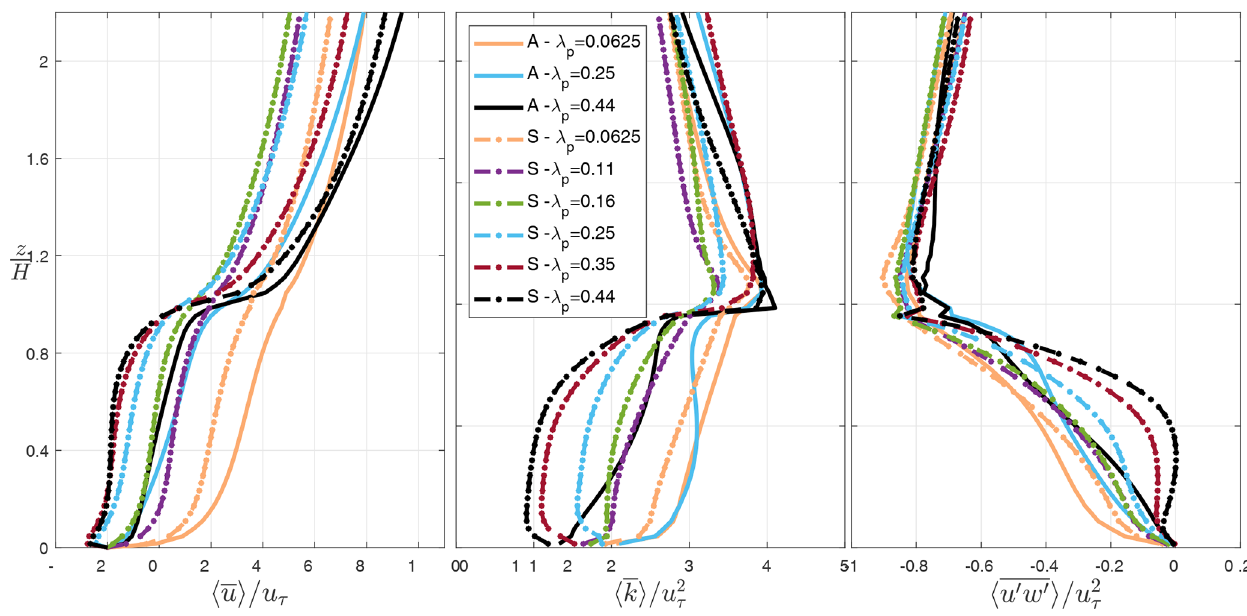
(cid:16) (cid:17) (cid:16) (cid:17) (cid:104) k (cid:105) /u 2 (cid:104) u (cid:48) w (cid:48) (cid:105) /u 2 , and turbulent momentum flux τ τ